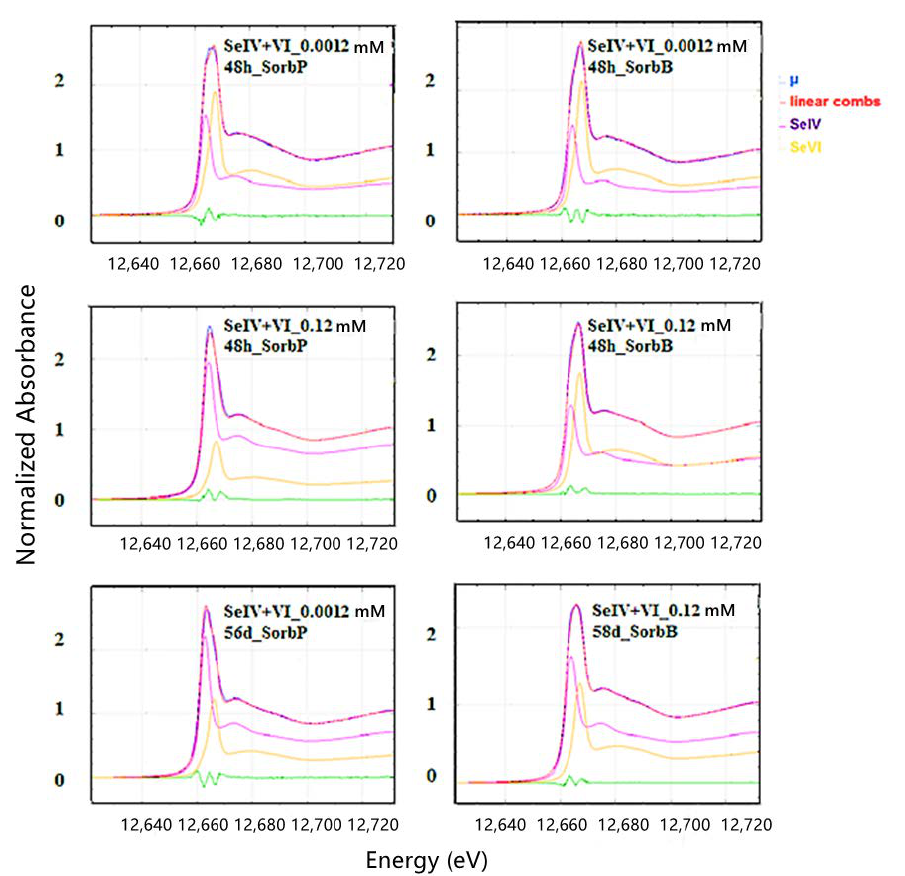
Figure 5. Se K-edge XANES results for Se(IV) and Se(VI) in mixture (ratio 1:1) adsorbed onto SorbP and SorbB (1 g/L) after 48 h and 56 d at pH 3.